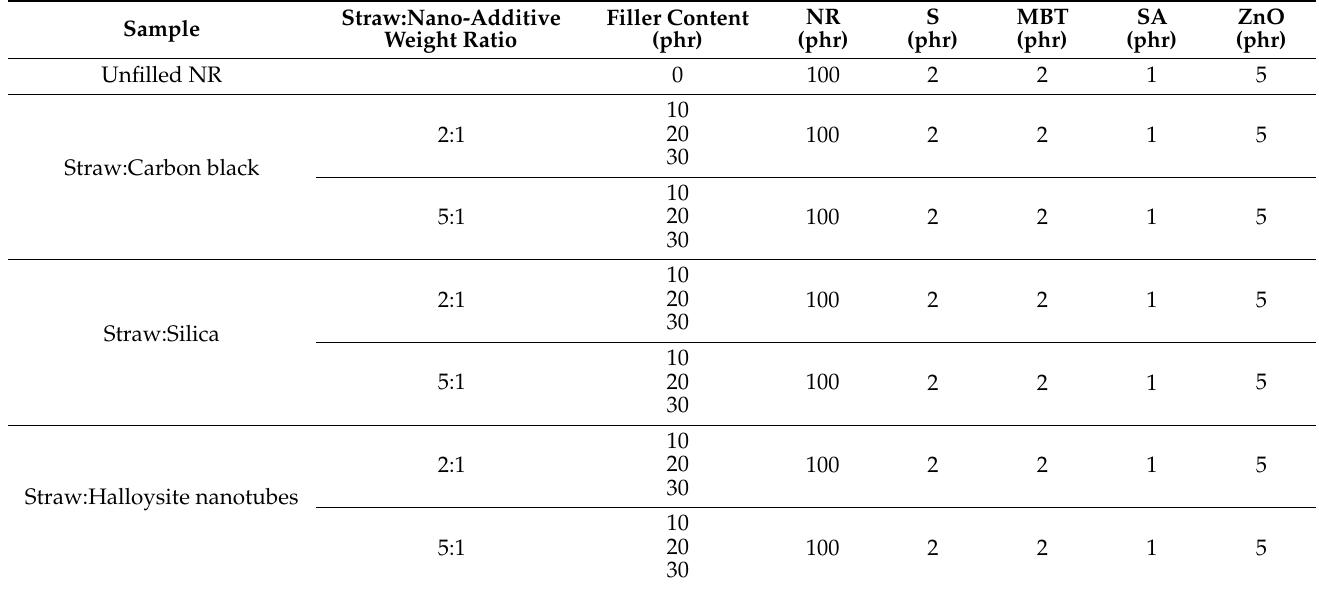
Table 1. Composition of elastomer